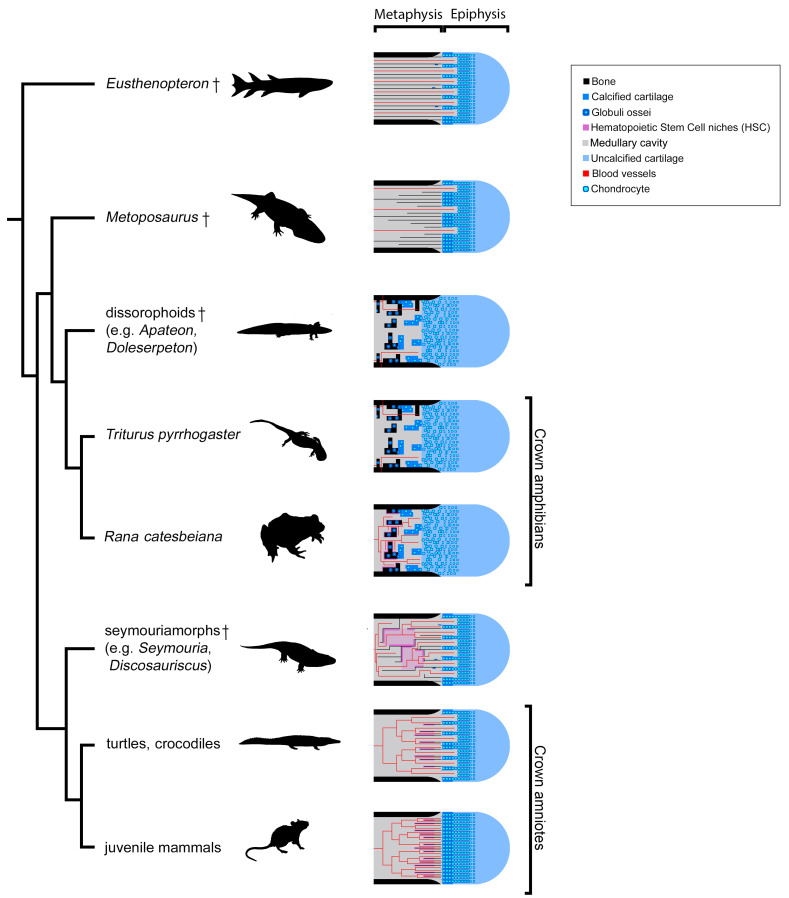
Evolution of growth-plate patterns and metaphyseal organisations of the long bones of the studied taxa in a phylogenetic context (e.g., Ruta and Coates, 2007; Schoch, 2019).Hypothesis on haematopoietic activity is herein contextualised. Black silhouettes represent the taxa studied. Crosses (†) have been attributed to fossil taxa.